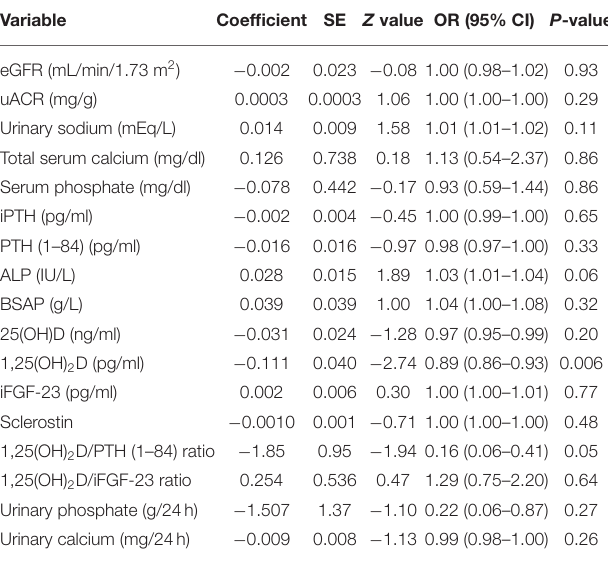
TABLE 3 | Univariate regression models for predicting WRF > 20% at 6